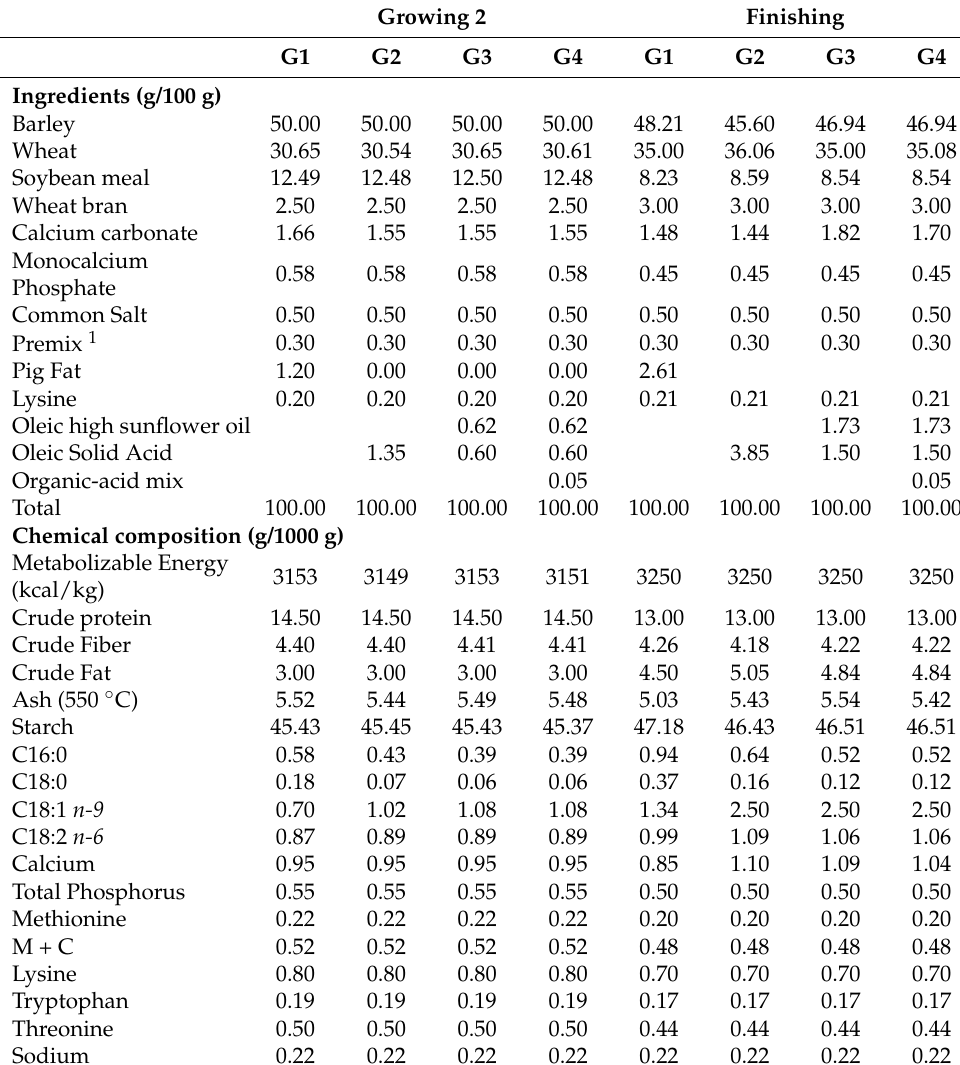
Table 2. Composition and nutrient contents of experimental